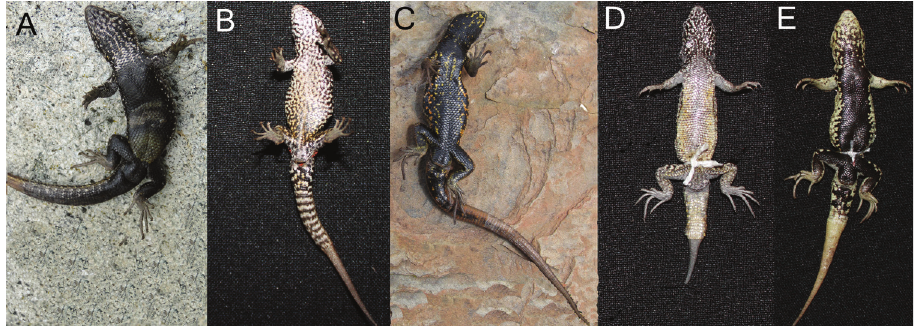
Figure 3. Ventral view showing the color patterns of the belly and tail: a Ancash B Ayacucho C Cusco D L. tacnae and e L. walkeri